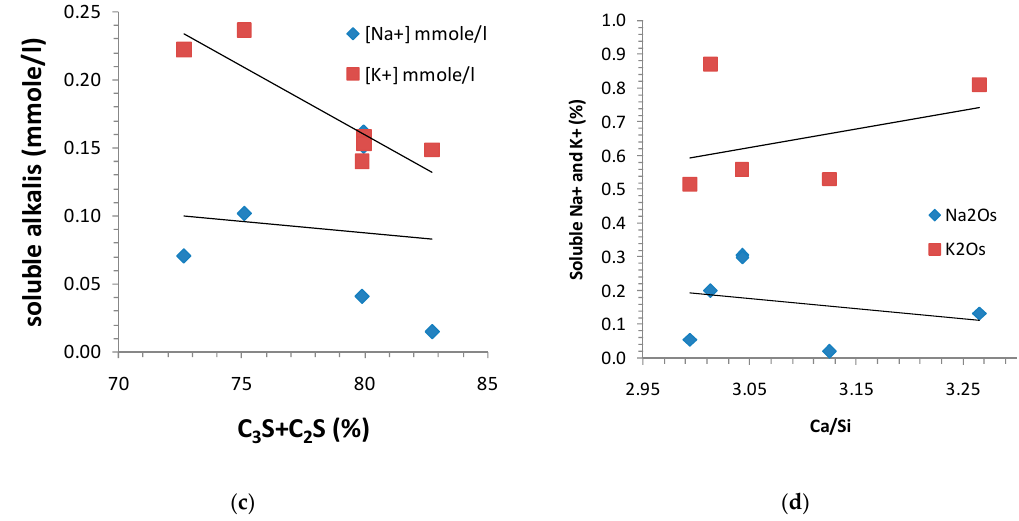
Figure 4. Effects of different factors on the soluble alkali concentrations in the pore solutions of hydrated Portland cement pastes: ( a ) C 3 S; ( b ) C 2 S; ( c ) C 3 S + C 2 S; ( d ) CaO/SiO 2 contents in clinker.